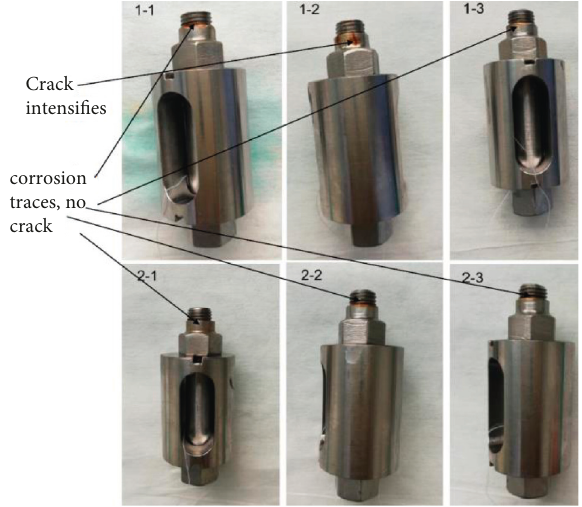
Figure 13: The surface condition of the test piece soaked in boiling magnesium chloride solution for 16 h.